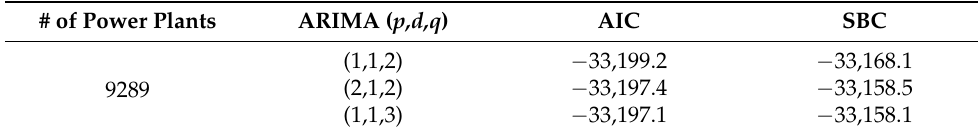
Table 4. Fitting of p , d , q of the ARIMA model for power plant #9289.